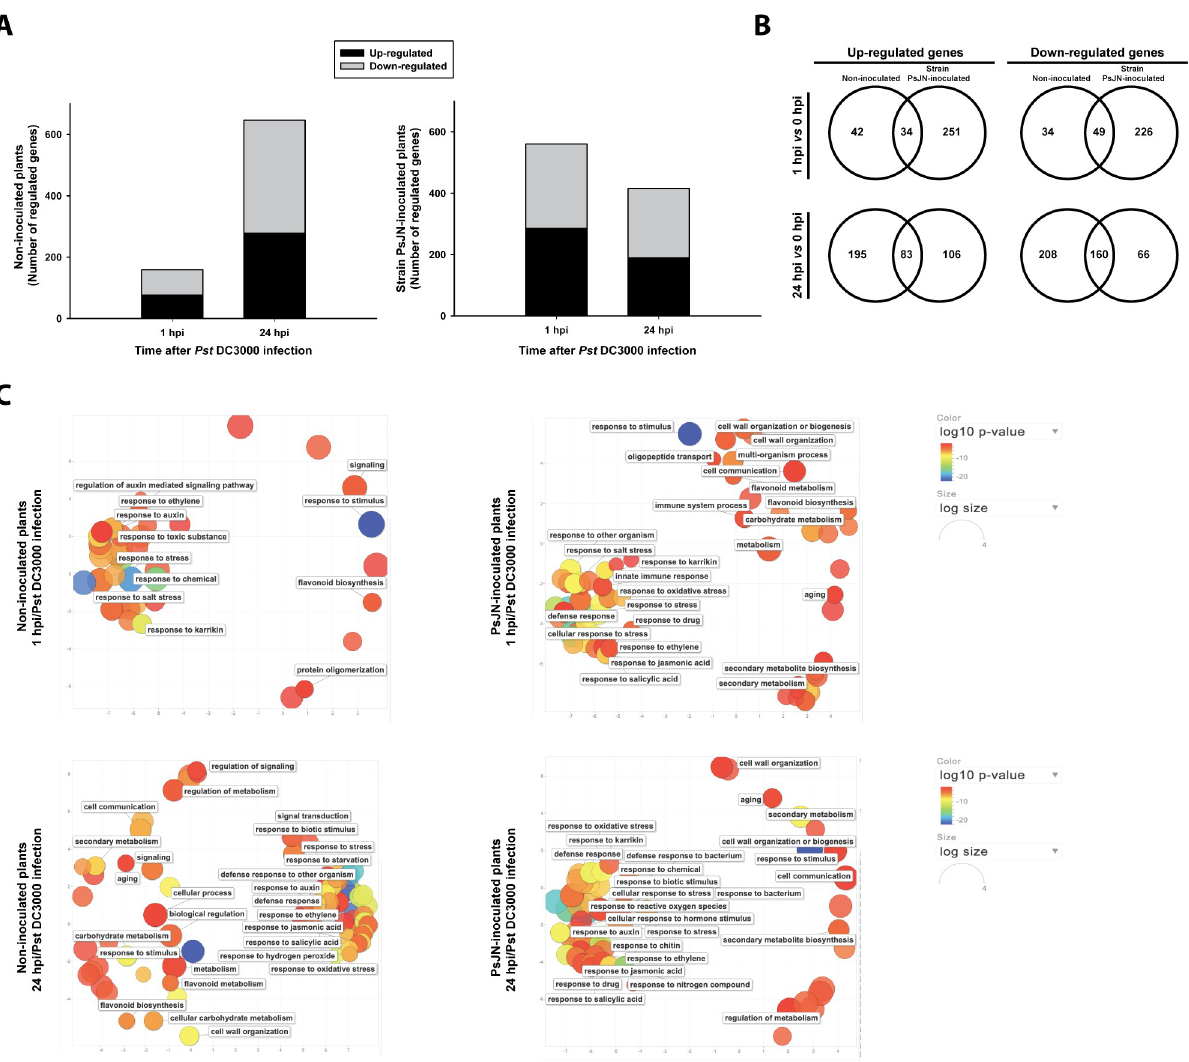
Fig 4. Gene regulation induced by Pseudomonas syringae DC3000 in Arabidopsis plants inoculated or non-inoculated with Paraburkholderia phytofirmans PsJN. Number of regulated genes at 1 and 24 hours post-infection (hpi) with Pst DC3000 in plants that were previously inoculated with strain PsJN (PsJN-inoculated plants, right panel in A) or were not inoculated with the same strain (Non-inoculated plants, left panel in A), all data were compared to 0 hpi (Rank-product, adjusted p < 0.05) (B) Venn diagrams of the data presented in (A) showing the overlap of genes that were either up- or down-regulated in Arabidopsis plants inoculated or non-inoculated with strain PsJN at 1 and 24 hpi of Pst DC3000 infection. Panel (C) shows biological processes affected by Pst DC3000 infection in PsJN- and non-inoculated plants (right and left panel, respectively) at 1 (upper figures) or 24 hpi (bottom figures). Gene Ontologies (GO) terms significantly enriched for biological processes ( p < 0.01) are represented by circles and clustered according to semantic similarities using the Revigo tool. Circle sizes are proportional to the number of genes in each GO term, whereas the color scale indicates the Log 10 p- value obtained in the enrichment analysis (red higher, blue lower).